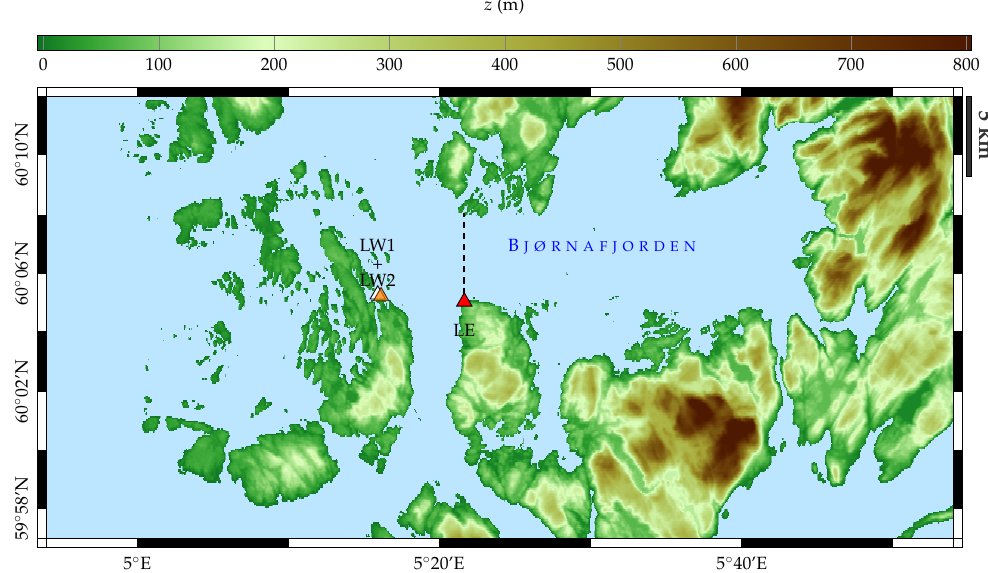
Figure 1. Location of the three pulsed wind lidars (triangles) in the Bjørnafjord and location of the planned fjord crossing (dashed